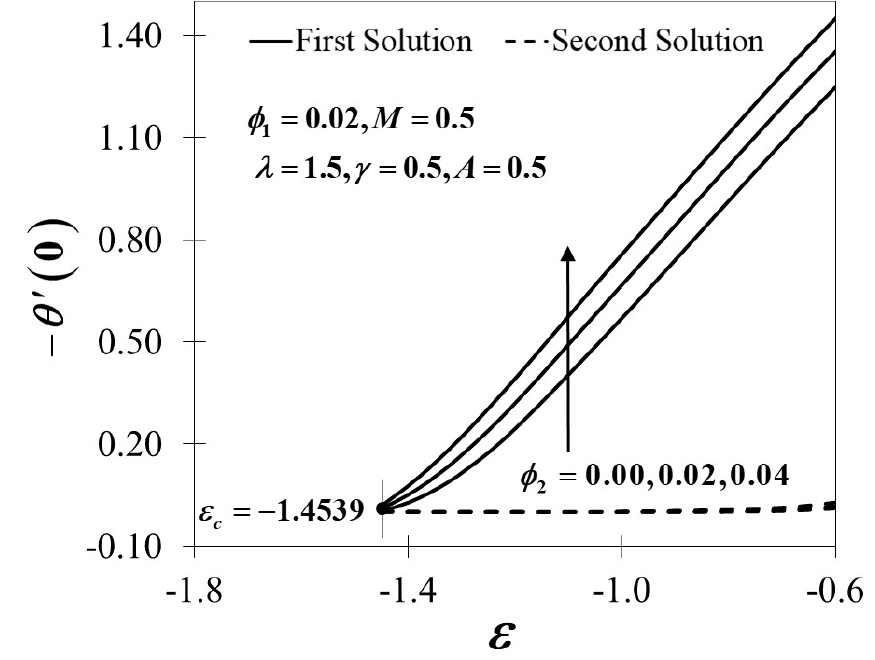
′′ for different values of 2 φ .